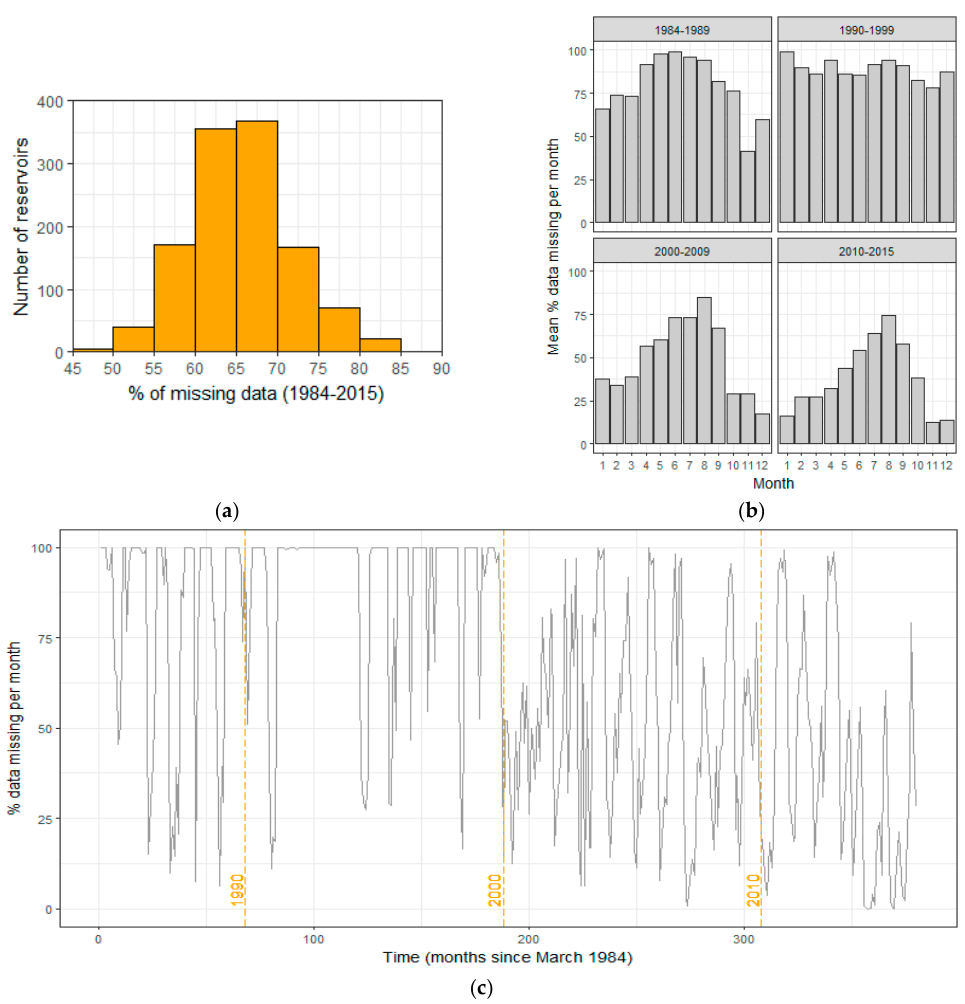
Figure A2. Data gaps in GSW-MH derived monthly reservoir area estimates for 1200 Volta basin reservoirs by ( a ) percentage of missing data for each reservoir, ( b ) mean percentage of missing data for each reservoir per month for each decade, and ( c ) percentage of reservoirs missing data for individual months.